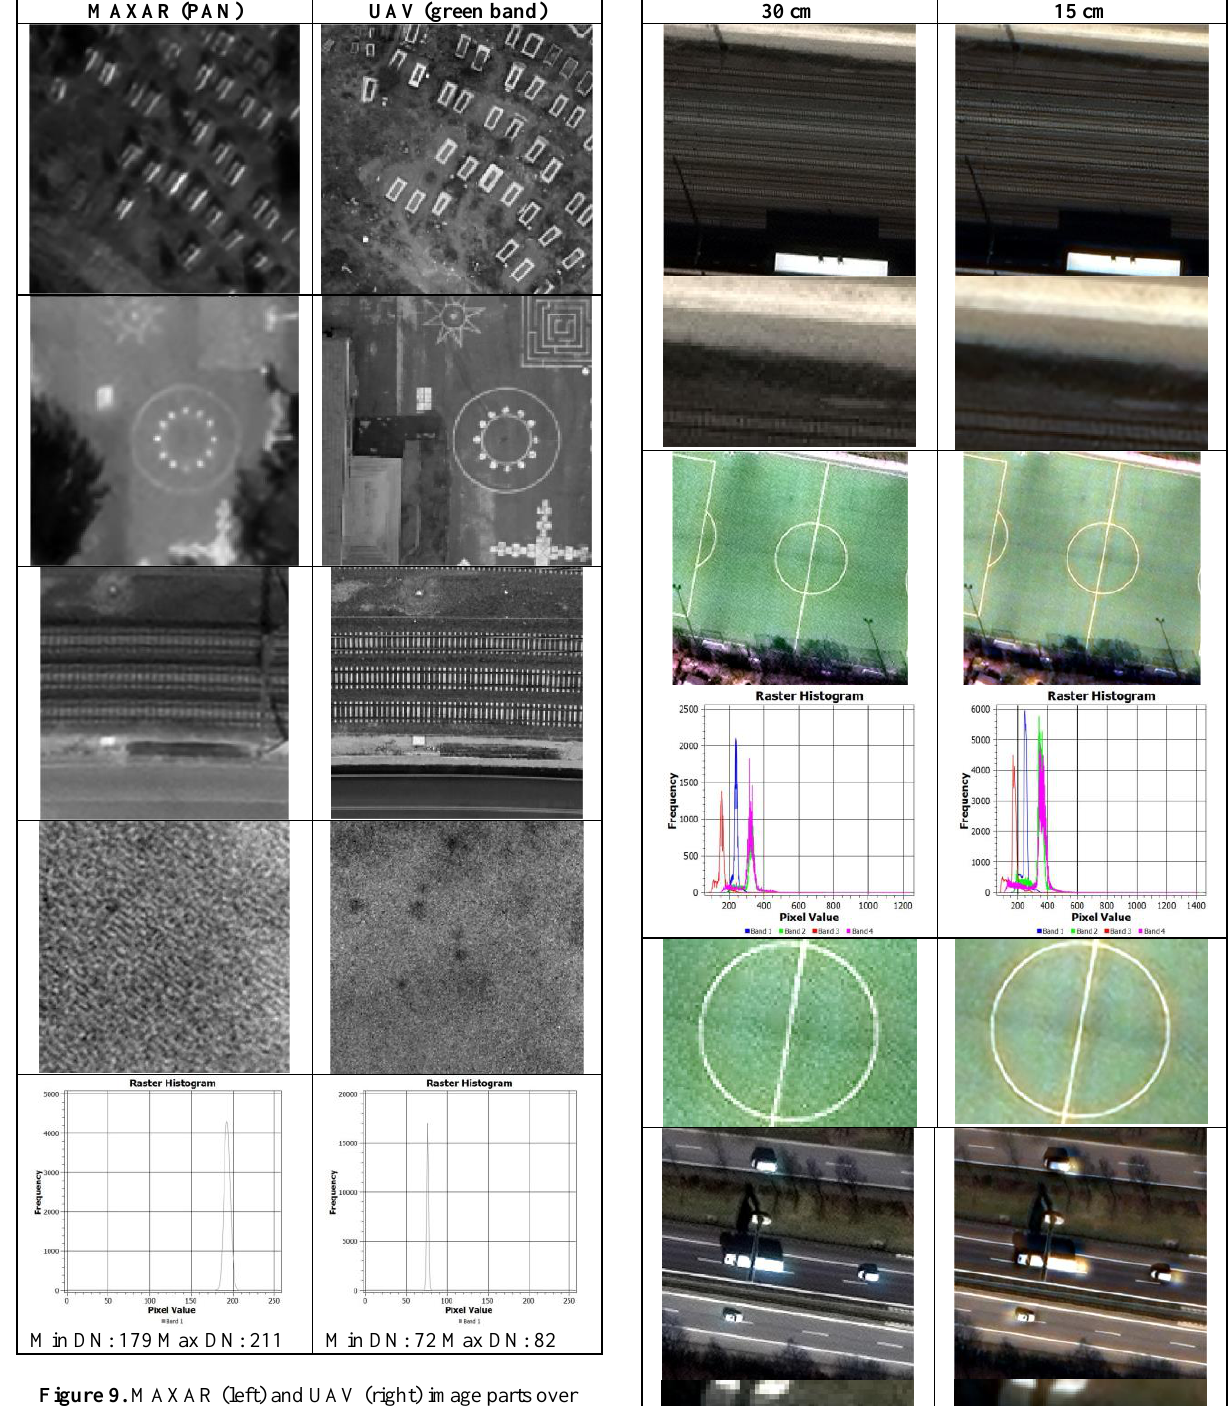
Figure 9. MAXAR (left) and UAV (right) image parts over Ankara testfield.